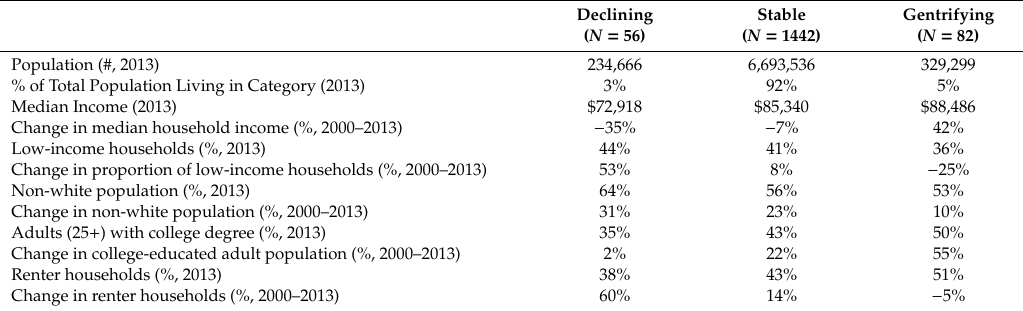
Table 2. The demographics of the Landis (3-D) Gentrification Typologies, the San Francisco Bay Area